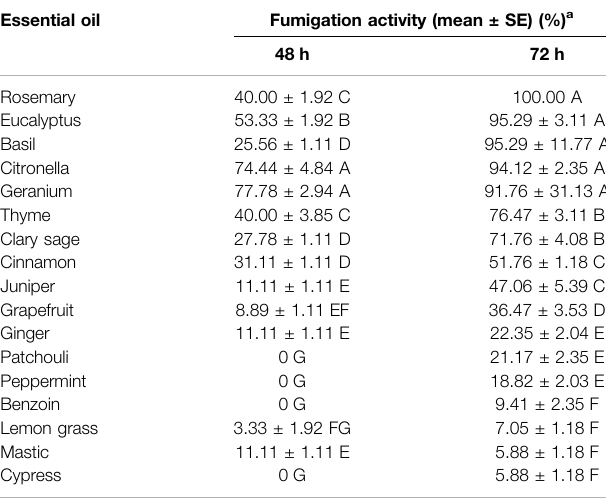
TABLE 1 | Fumigation activity of 17 kinds of plant essential oils against L. serricorne adults at 15 μ l/L. Essential